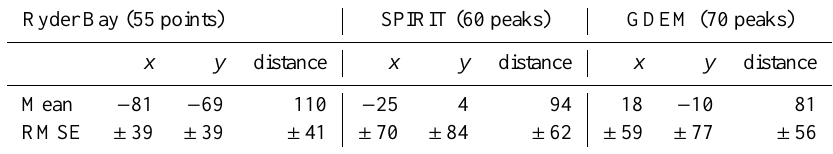
Table 5. Horizontal di ff erences (in metres) from the Landsat Image Mosaic of Antarctica (LIMA). Ryder Bay (55